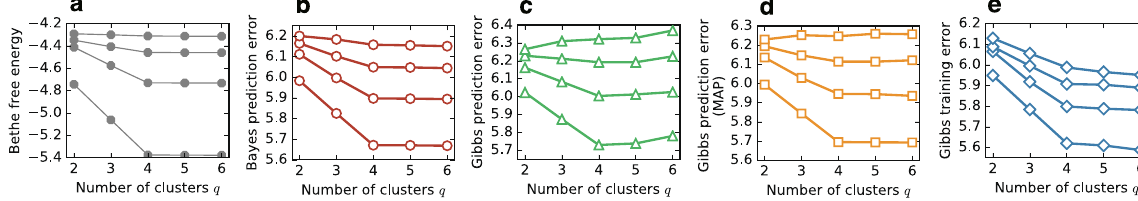
Figure 6. Performance of the model assessment criteria on various stochastic block models. The results of ( a ) Bethe free energy, ( b ) Bayes prediction error E Bayes , ( c ) Gibbs prediction error E Gibbs , ( d ) MAP estimate of the Gibbs prediction error E MAP , and ( e ) Gibbs training error E training are shown. The lines in each plot represent the results of various values of 